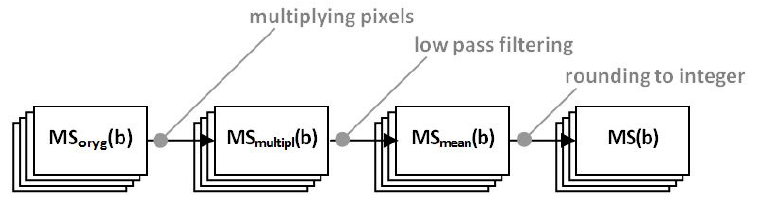
Figure 3. Diagram of preliminary preparation of multispectral data for the integration process.